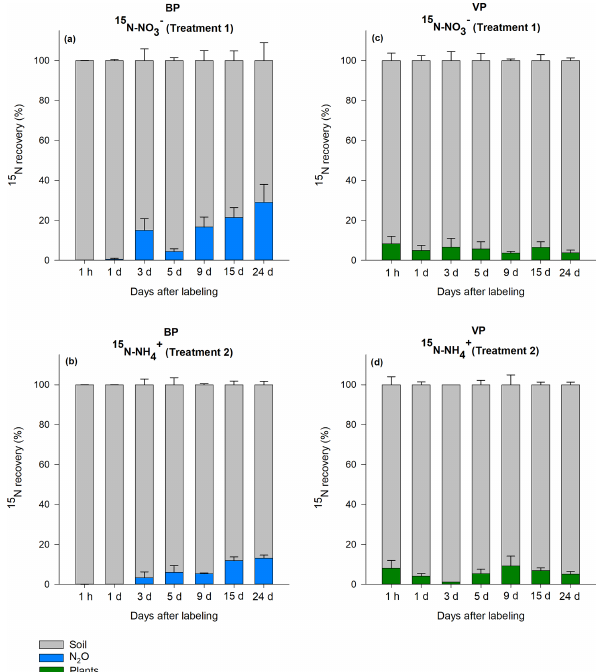
Figure 2. Relative distribution of the 15 N label recovered from the bare peat (BP) and vegetated peat (VP) soil for T1 (NH 4 15 NO 3 ) and T2 ( 15 NH 4 NO 3 ). Data are mean values ± SE ( n = 3).